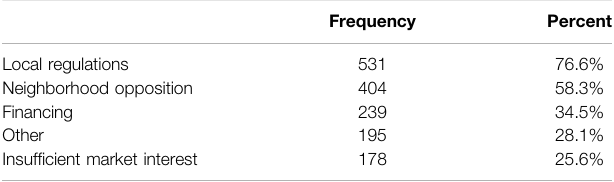
TABLE 2 | Challenges encountered to mixed-use development 2004 (Levine and Inam, 2004).